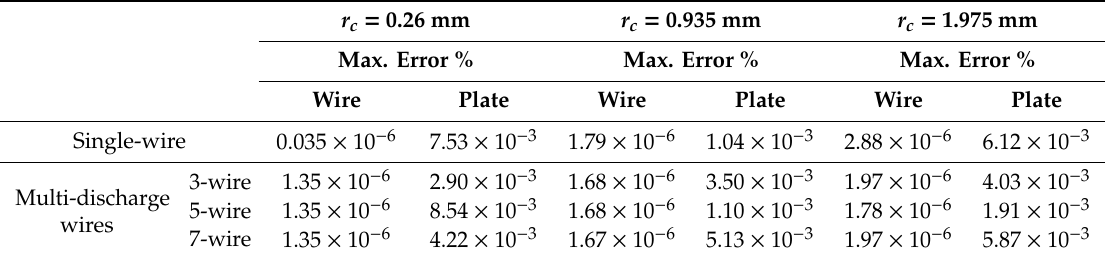
Table 2. Accuracy of using charge simulation method (CSM) in calculating the corona-onset voltage of WDESP.